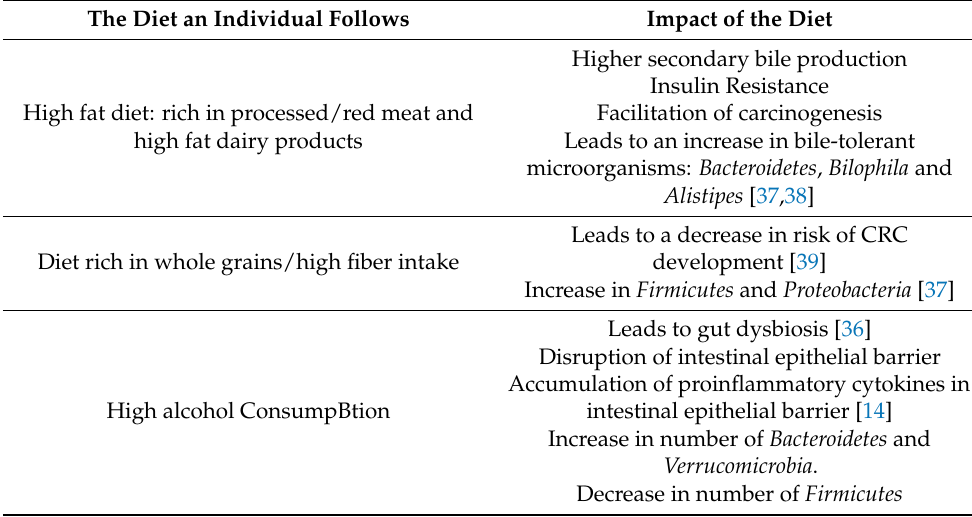
Table 3. The diet an individual follows plays a major role in their chances of developing CRC. Moreover, the diet an individual follows impacts the diversity of microorganisms inhabiting the gut. Alterations in the gut microbiome leads to an increased risk of CRC development. The Diet an Individual Follows Impact of the Diet Higher secondary bile production Insulin Resistance Facilitation of carcinogenesis High fat diet: rich in processed/red meat and Leads to an increase in bile-tolerant high fat dairy products microorganisms: Bacteroidetes , Bilophila and Alistipes [37,38] Leads to a decrease in risk of CRC Diet rich in whole grains/high fiber intake development [39] Increase in Firmicutes and Proteobacteria [37] Leads to gut dysbiosis [36] Disruption of intestinal epithelial barrier Accumulation of proinflammatory cytokines in High alcohol ConsumpBtion intestinal epithelial barrier [14] Increase in number of Bacteroidetes and Verrucomicrobia . Decrease in number of